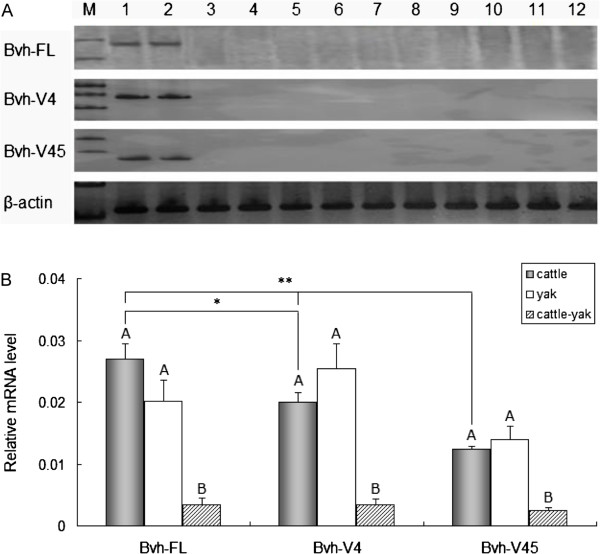
The expression of Bvh gene and its splice variants. A. The expression profile of Bvh and its splice variants in cattle, yak and cattle-yak hybrid. DNA marker (M) was DL100. Line1-12 were testis, ovary, epididymis, glandula accessoria, hypophysis, hypothalamus, heart, liver, spleen, kidney, lung and muscle, respectively. B. The mRNA expression levels of Bvh gene and its splice variants in cattle, yak and cattle-yak hybrid. Different uppercase letters represent the difference of expression levels among populations are significant (P < 0.01). * indicate the significantly difference (P < 0.05), ** indicate the significantly difference (P < 0.01).